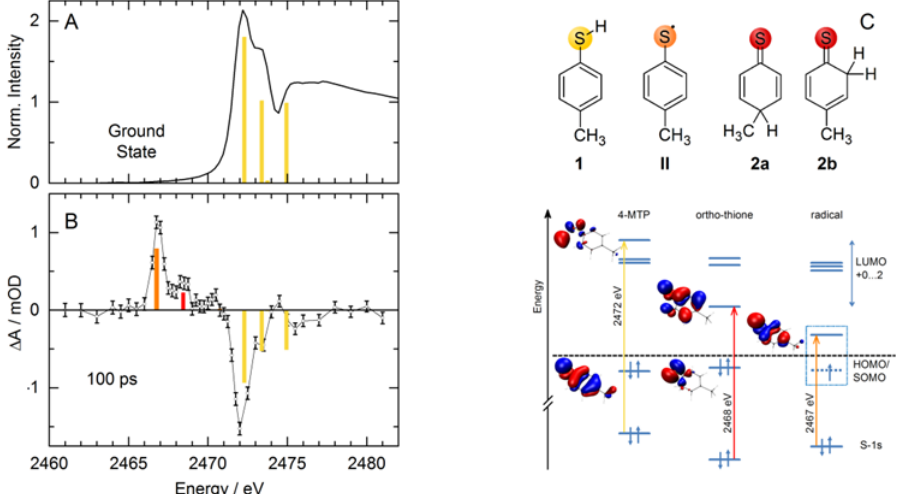
Fig. 1. A. Static sulfur-1s spectrum of 4MTP. 100 ps. The identified species are shown in panel the corresponding relevant frontier